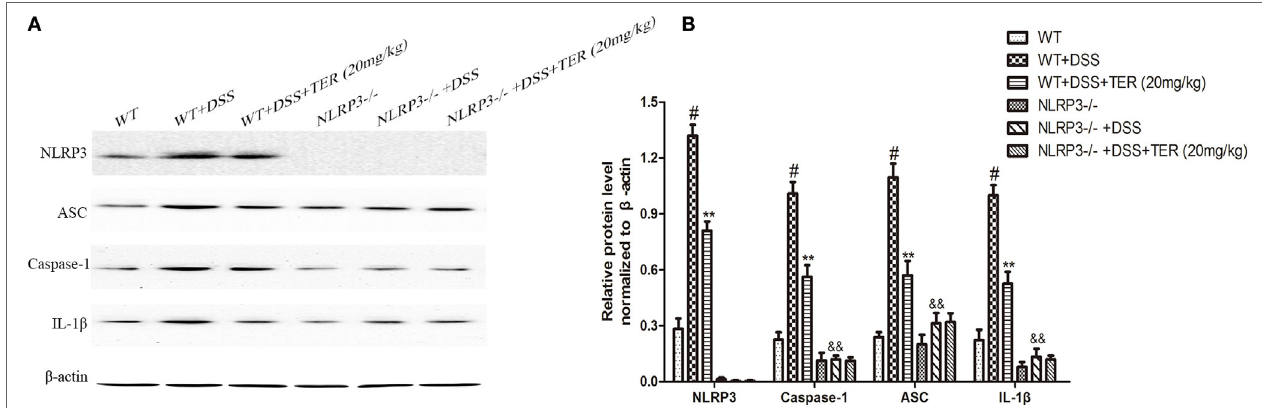
FigUre 5 | nlrP3 inflammasome plays an important role in the development of dextran sulfate sodium (Dss)-induced acute colitis . (a) Expressions of NLRP3, ASC, caspase-1, and interleukin-1 β (IL-1 β ) in colon tissues were examined by western blotting. (B) The relative protein expressions of NLRP3, ASC, caspase-1, and IL-1 β were normalized to β -actin. Data are presented as means ± SD ( n = 3). * p < 0.05 and ** p < 0.01 vs the group treated with only DSS; # p < 0.05 vs the control group. && p < 0.01 NLRP3 − / − vs wild-type mice in the group treated with only DSS.